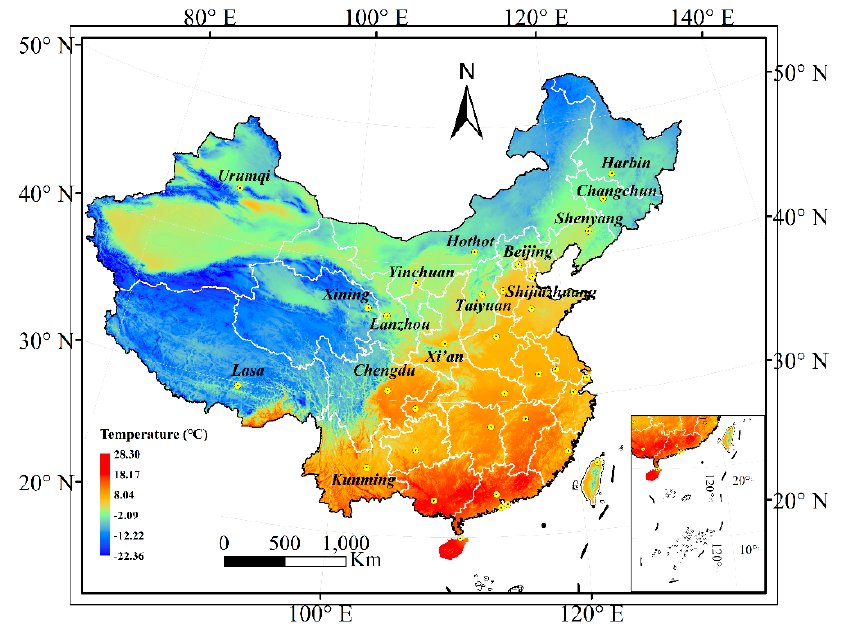
Figure 1. The mean annual air temperature distribution of China in 2015 [16].